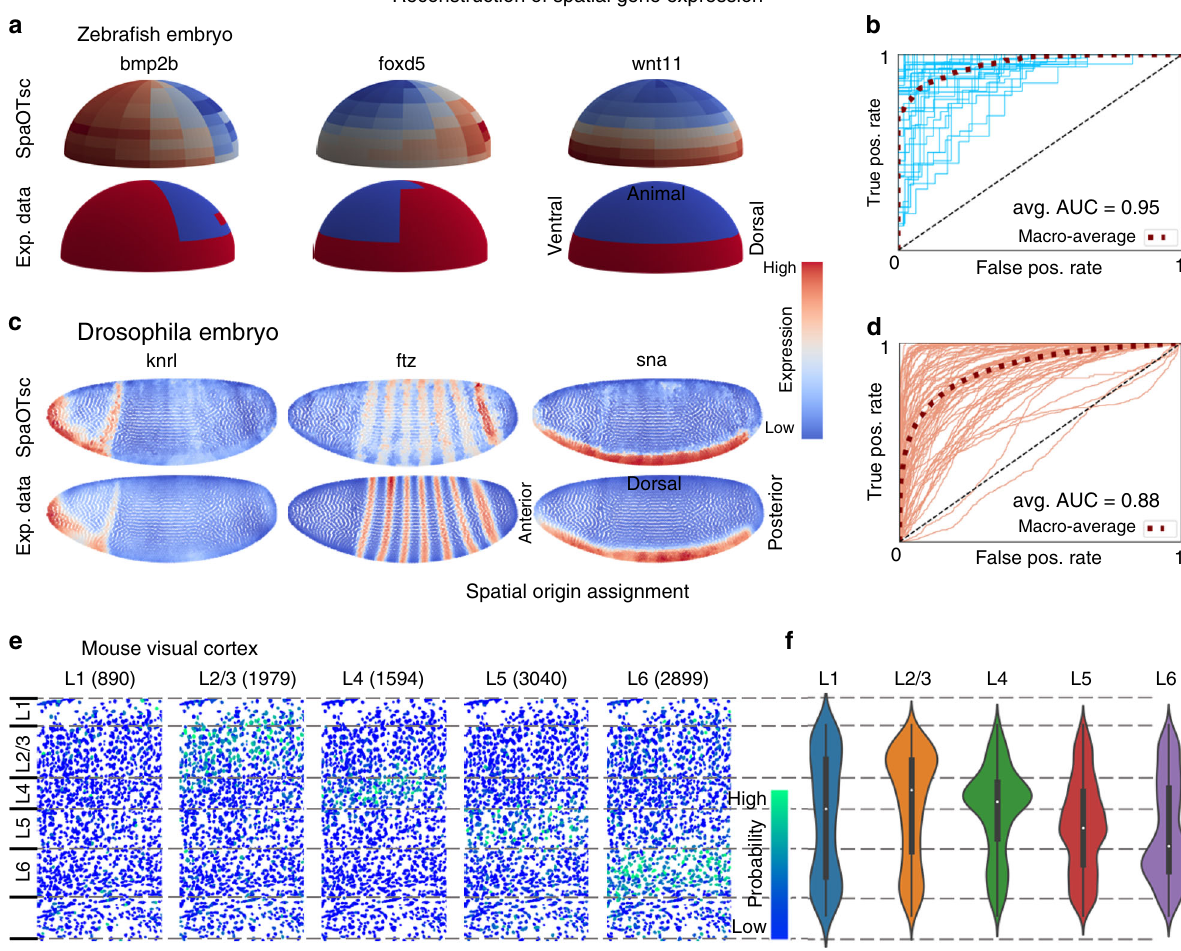
Fig. 2 Validation of SpaOTsc using three systems. a Predicted spatial expressions for the zebra fi sh embryo (both data from ref. 13 ). b The receiver operating characteristics (ROC) curves of leave-one-out cross-validation (LOO CV) of the spatial expression prediction for the zebra fi sh embryo data. c Predicted spatial expressions for the Drosophila embryo (both data from ref. 10 ). d The ROC curves of LOO CV of the spatial expression prediction for the Drosophila embryo spatial data. e Assignment of spatial positions to the scRNA-seq data for the mouse visual cortex (spatial data from ref. 38 ; scRNA-seq data from ref. 37 ). Each column depicts all cells from the spatial data in the visual cortex. For example, in column one, the color of cells represents the average probability of the spatial origin of the 890 cells in scRNA-seq data labeled with spatial origin L1. f Violin plots along L1-L6 axis of the mapped spatial origins for single cells from each subregion. Inside the violin plots are standard boxplots (median, 25th perceltile, 75th percentile, the bigger of minimum value and 25th percentile – 1.5 interquartile range, and smaller of maximum value and 75th percentile + 1.5 interquartile range). The numbers of data points for the violin plots from left to right are 890, 1979, 1594, 3040, 2899, respectively. Table 1 Performance comparison by leave-one-out cross-validation of spatial gene expression prediction. SpaOTsc DistMap Achim Seurat (v1)